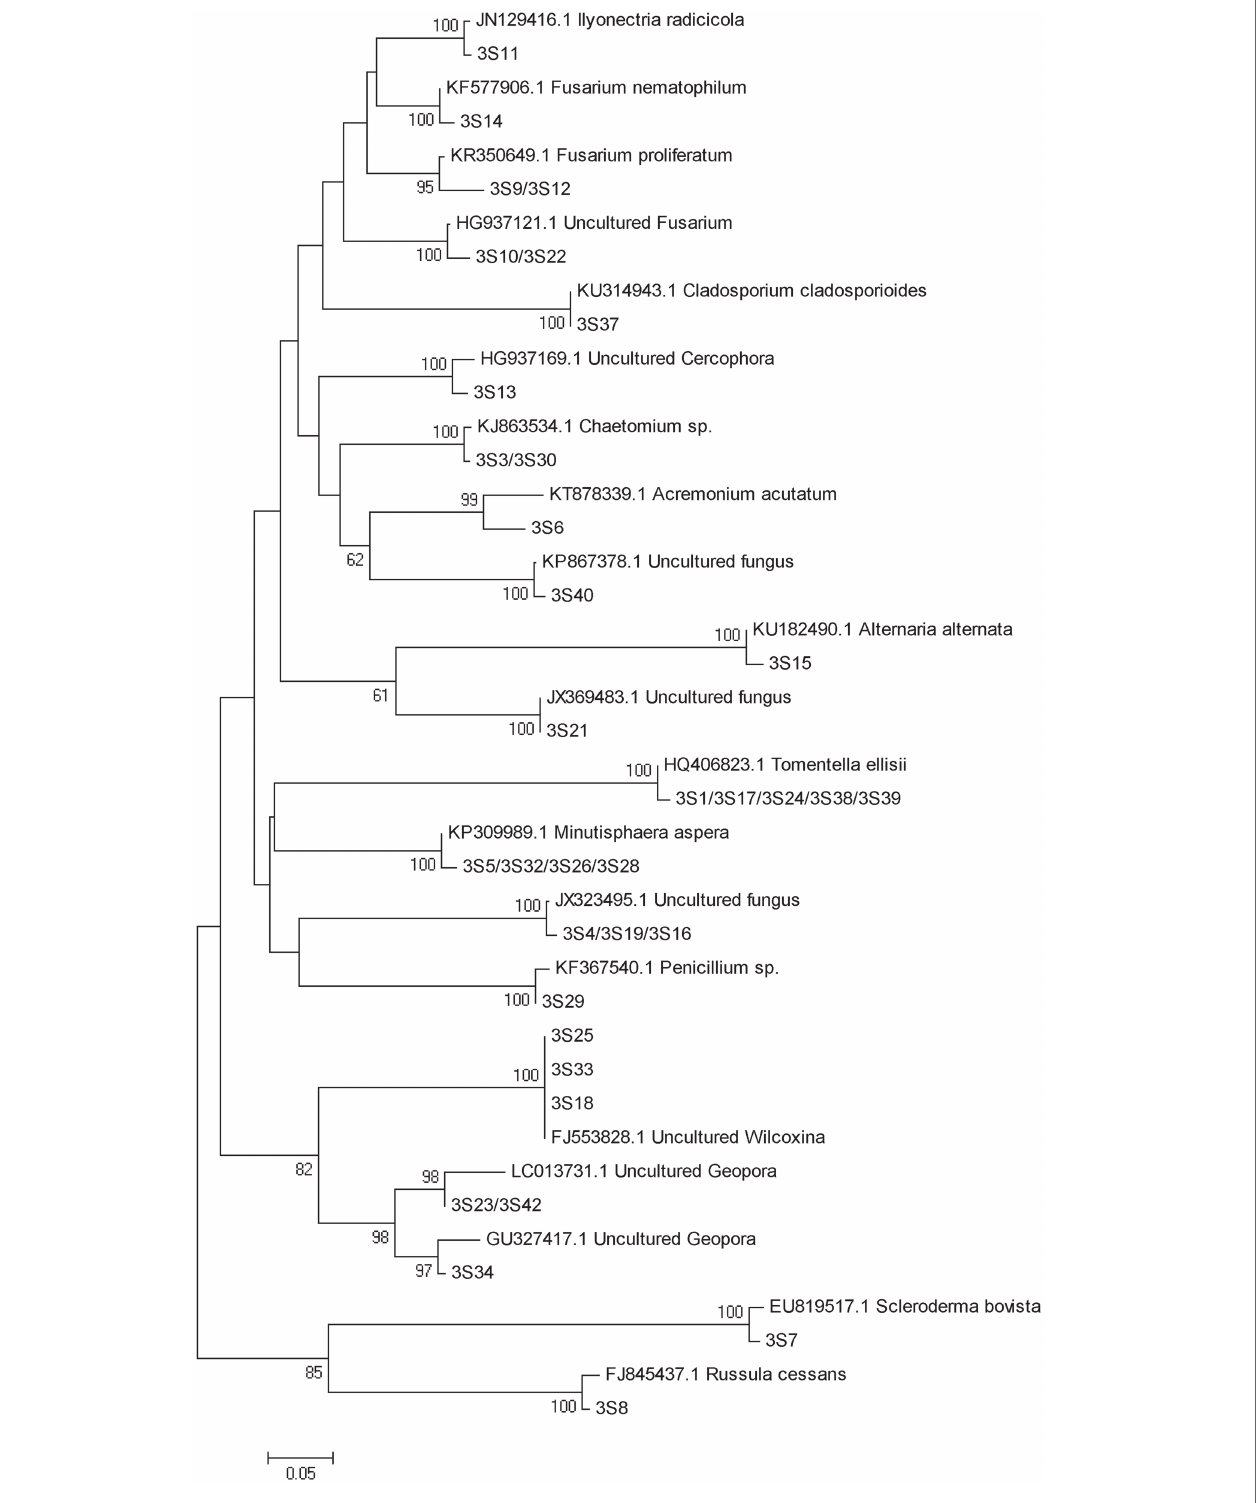
FIGURE 6 | Neighbor-joining phylogenetic tree of fungi at 3 months after PWN infection. According to the distribution of ITS rRNA gene fragments in DGGE gel electrophoresis in Figure 3A , some common and unique bands’ sequences were recovered from the DGGE gels and performed phylogenetic analysis with reference sequences. Bootstrap values (out of 1,000) were shown when they exceed 60% (Same as